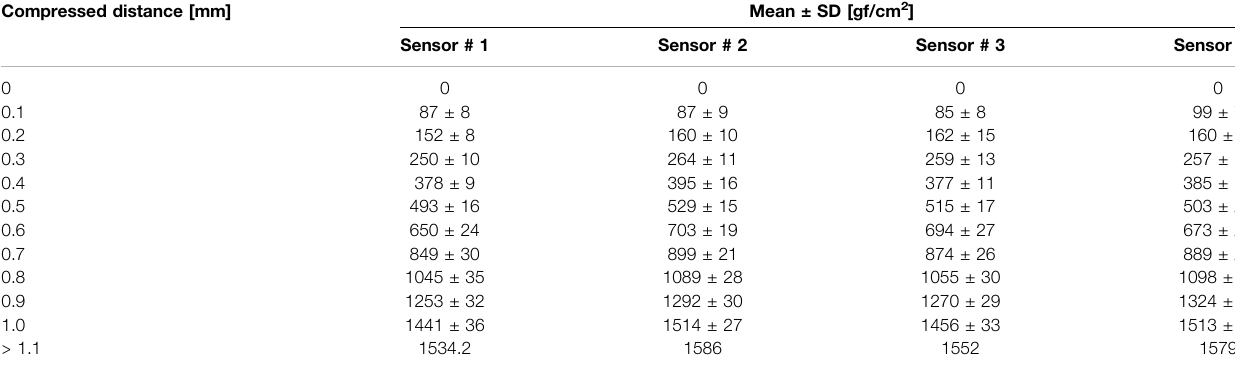
TABLE 1 | Summary of pressure values according to the compressed distance of force sensor